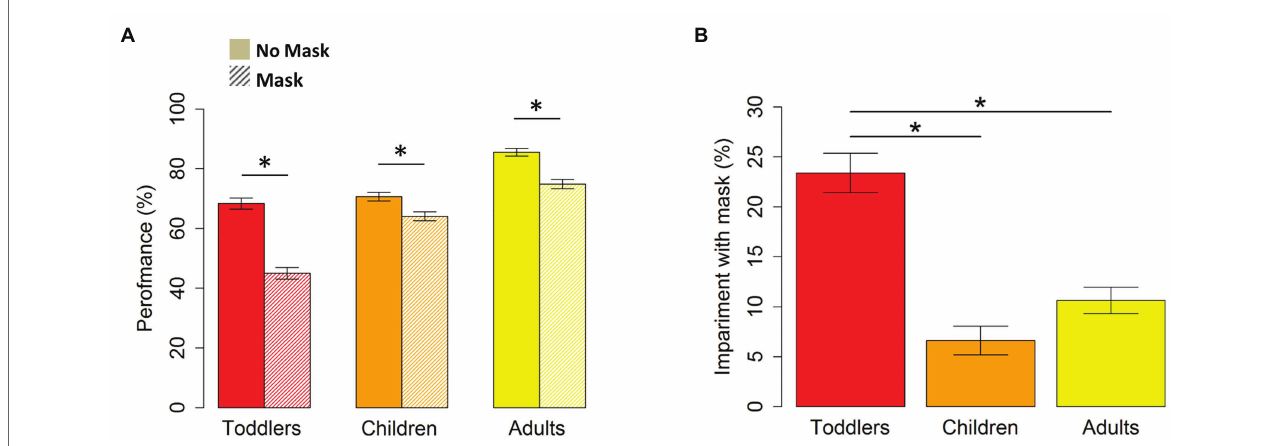
FIGURE 1 | (A) Percentage of correct responses without and with the masks in toddlers, children, and adults. (B) Percentage of impairment due to masks in toddlers, children, and adults. Impairment is calculated as the difference between the percentage of correct responses without and with the masks. The SEM is reported. The stars indicate a significant difference between the groups ( p <